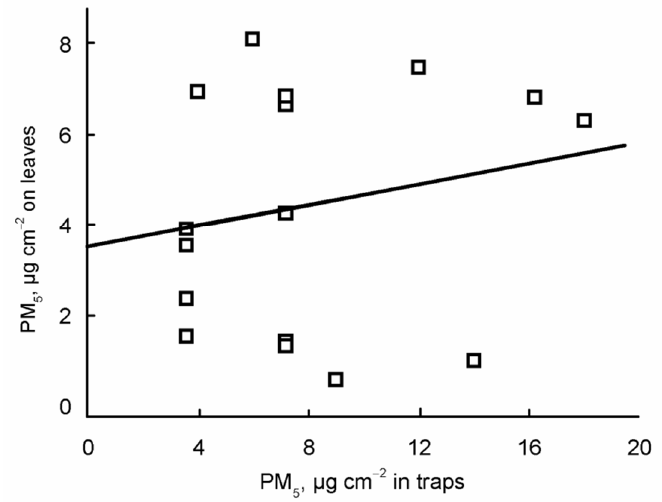
Figure 5. Scatter plot of the PM concentration on leaves and dust traps based on the PM. The regression line is also indicated.